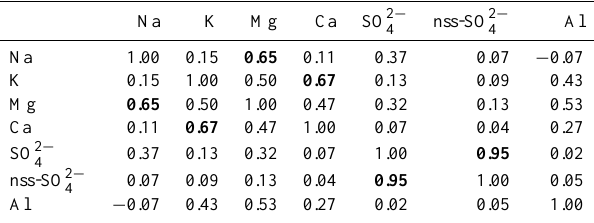
Table 2. Correlation coefficients between mean element concentra- tions (2006–2008) along the Progress–Vostok traverse. Significant correlations ( p < 0.05, n = 13) are marked in